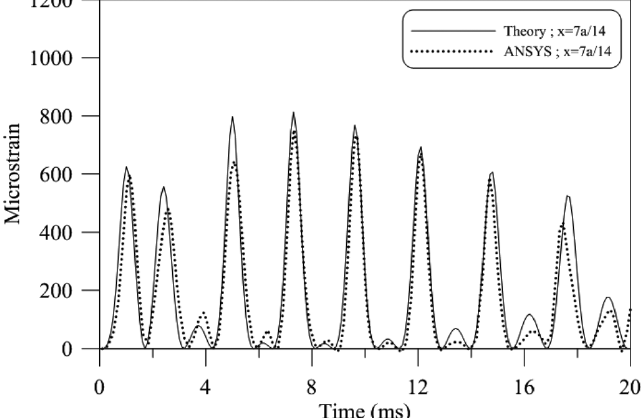
Fig. 9. The strain-time history ( ε xm − t ) at middle surface of point (7a/14, b/2).